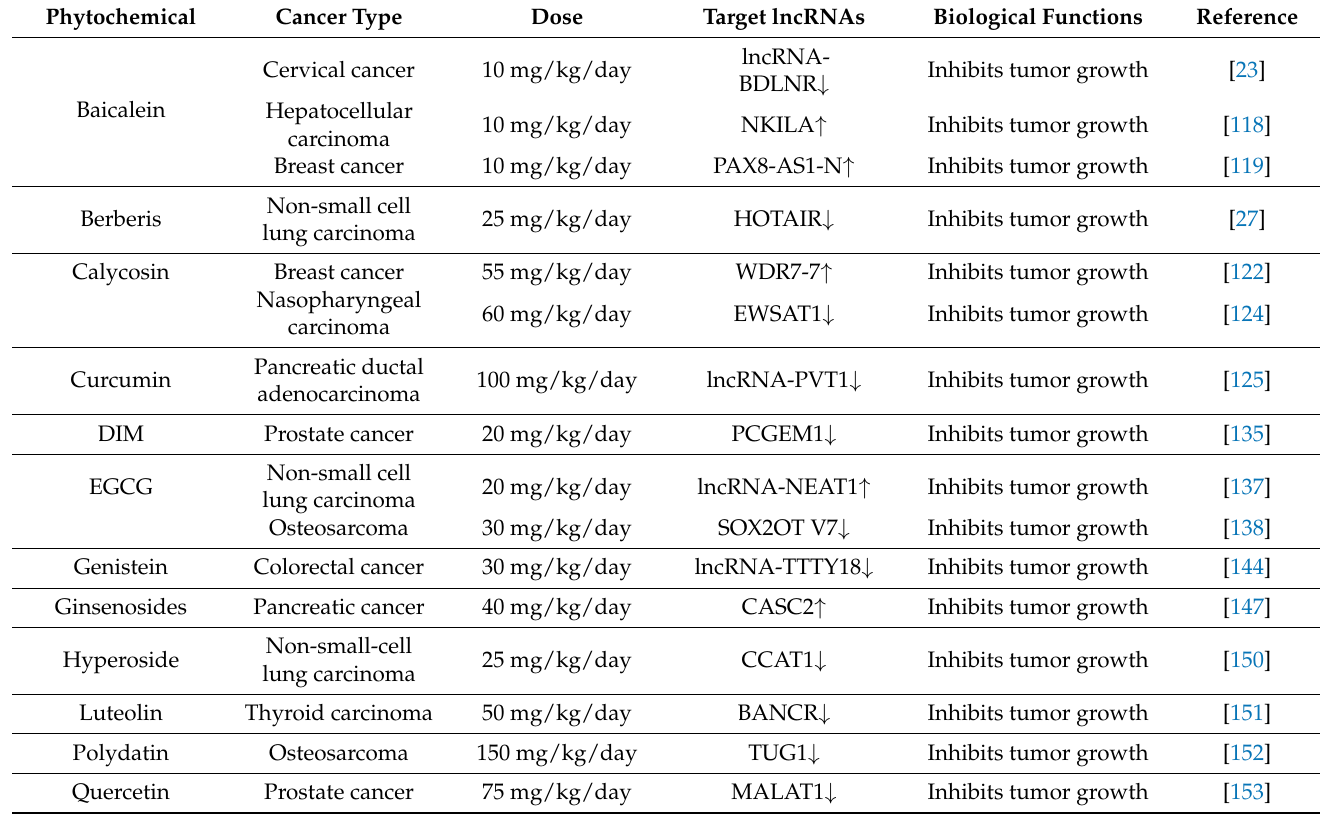
Table 3. In vivo regulatory effects of phytochemicals on lncRNAs in various mouse xenograft tumor models.